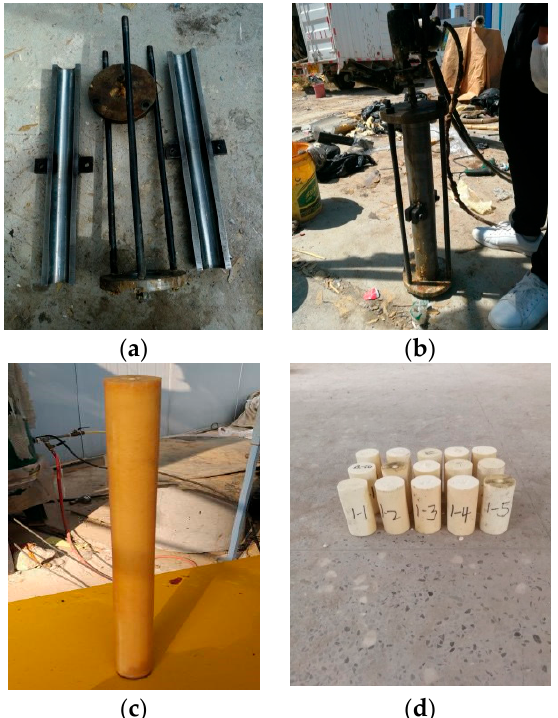
Figure 2. Schematic diagram of specimen forming process. ( a ) Self-made mold drawing, ( b ) grouting molding, ( c ) specimen after mold removal, ( d ) numbered specimens.